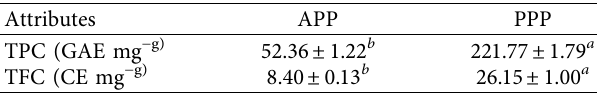
Table 3: Proximate chemical analysis of apple pomace powder and pomegranate peel